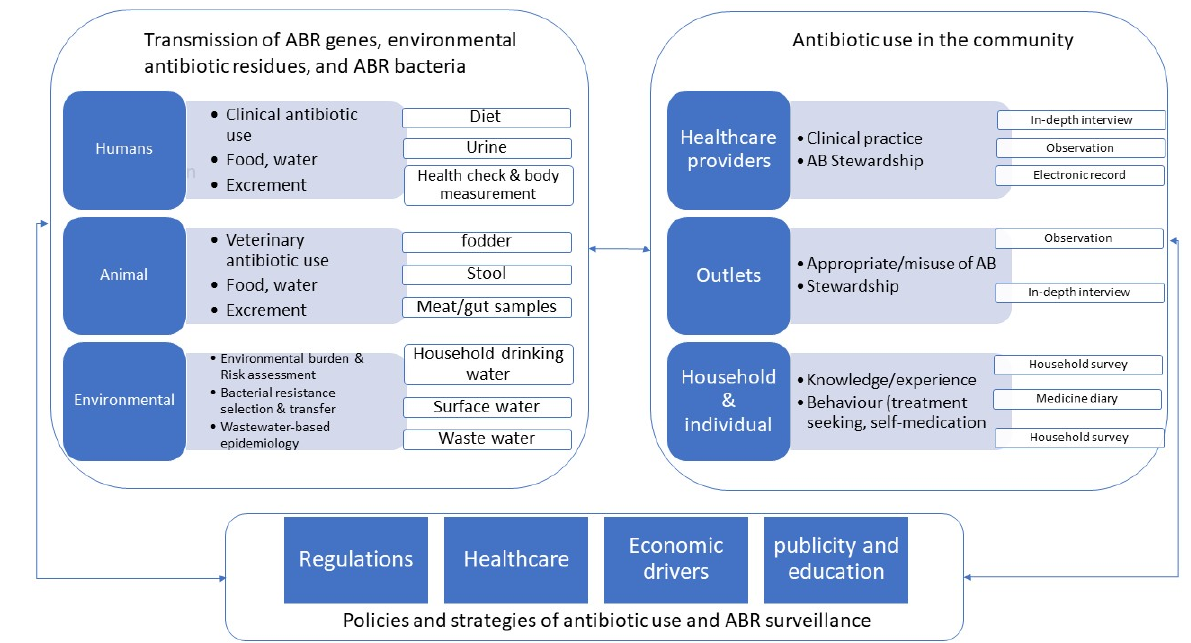
Figure 1. Description of study design and quantitative and qualitative data collection.